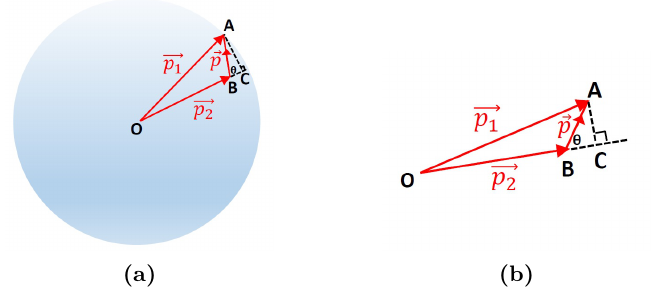
Figure 3. An illustration describing the momentum space notation corresponding to the integral in the expression for the spectral density (6.38) for a specific configuration of ~p : as p → 0 , 1 , ~p 2 , and p + p cos θ ≈ p . Thus the variable δp ranges from − p cos θ to 0 in p → 0 p 1 → p + 2 F 2 ≡ p 2 − p F F limit. This will be useful in evaluation (6.39). Figure 3a describes a Fermi surface of radius p in F this specific configuration in momentum space, while figure 3b zooms in on the triangle AOB